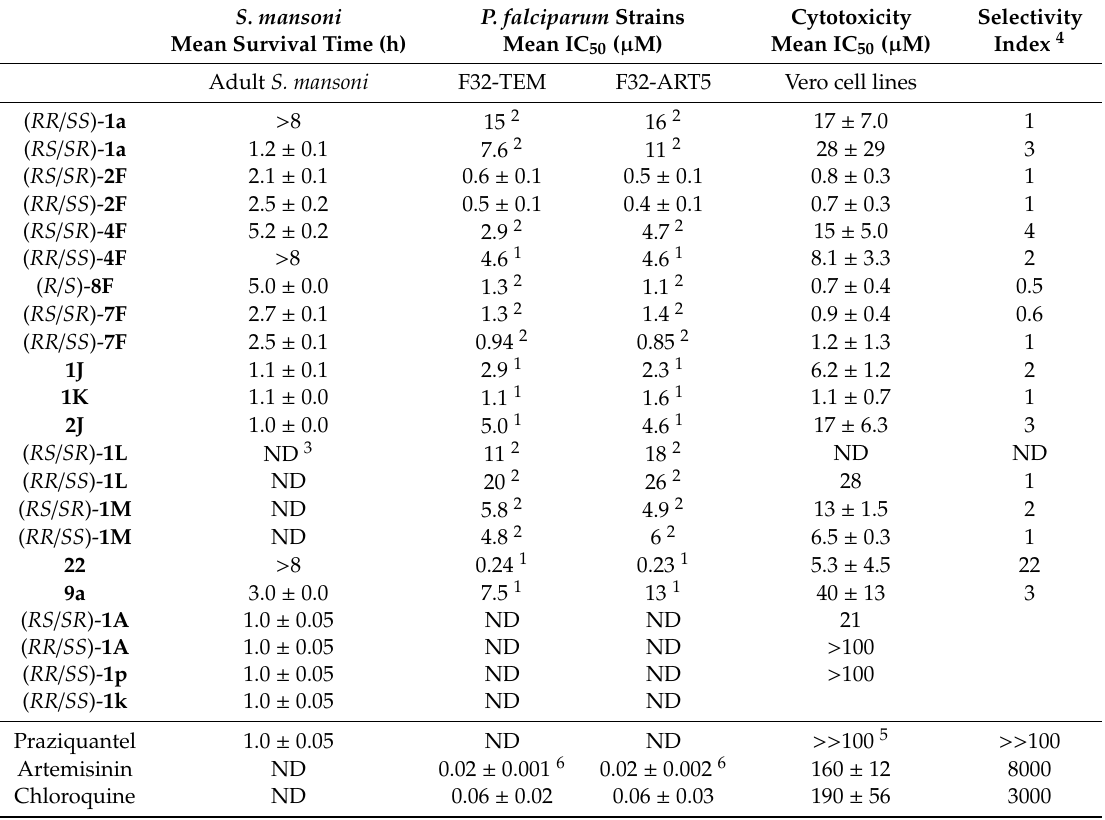
Table 1. Antiplasmodial and antischistosomal activities detailed for the best alkoxyamines and cytotoxicity on Vero cell